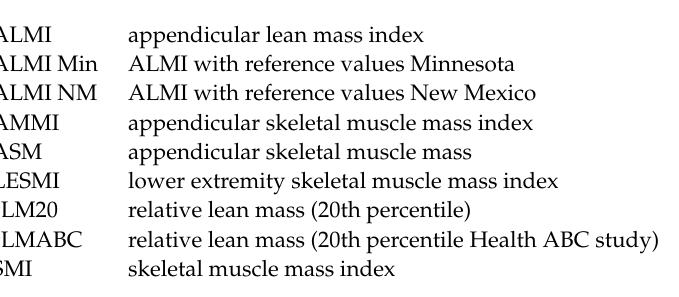
adjusted parameters per sex or BMI group. Table S4: Detailed results of binary logistic regressions analysis. Table S5: Percent of reliability of sarcopenia diagnosis according to gender. Table S6: Percent of reliability of sarcopenia diagnosis according to BMI subgroups. Table S7: Validation of multiple IDs in the follow-up visit per BMI or sex. Chapter: S1. Detailed results on sarcopenia prevalence